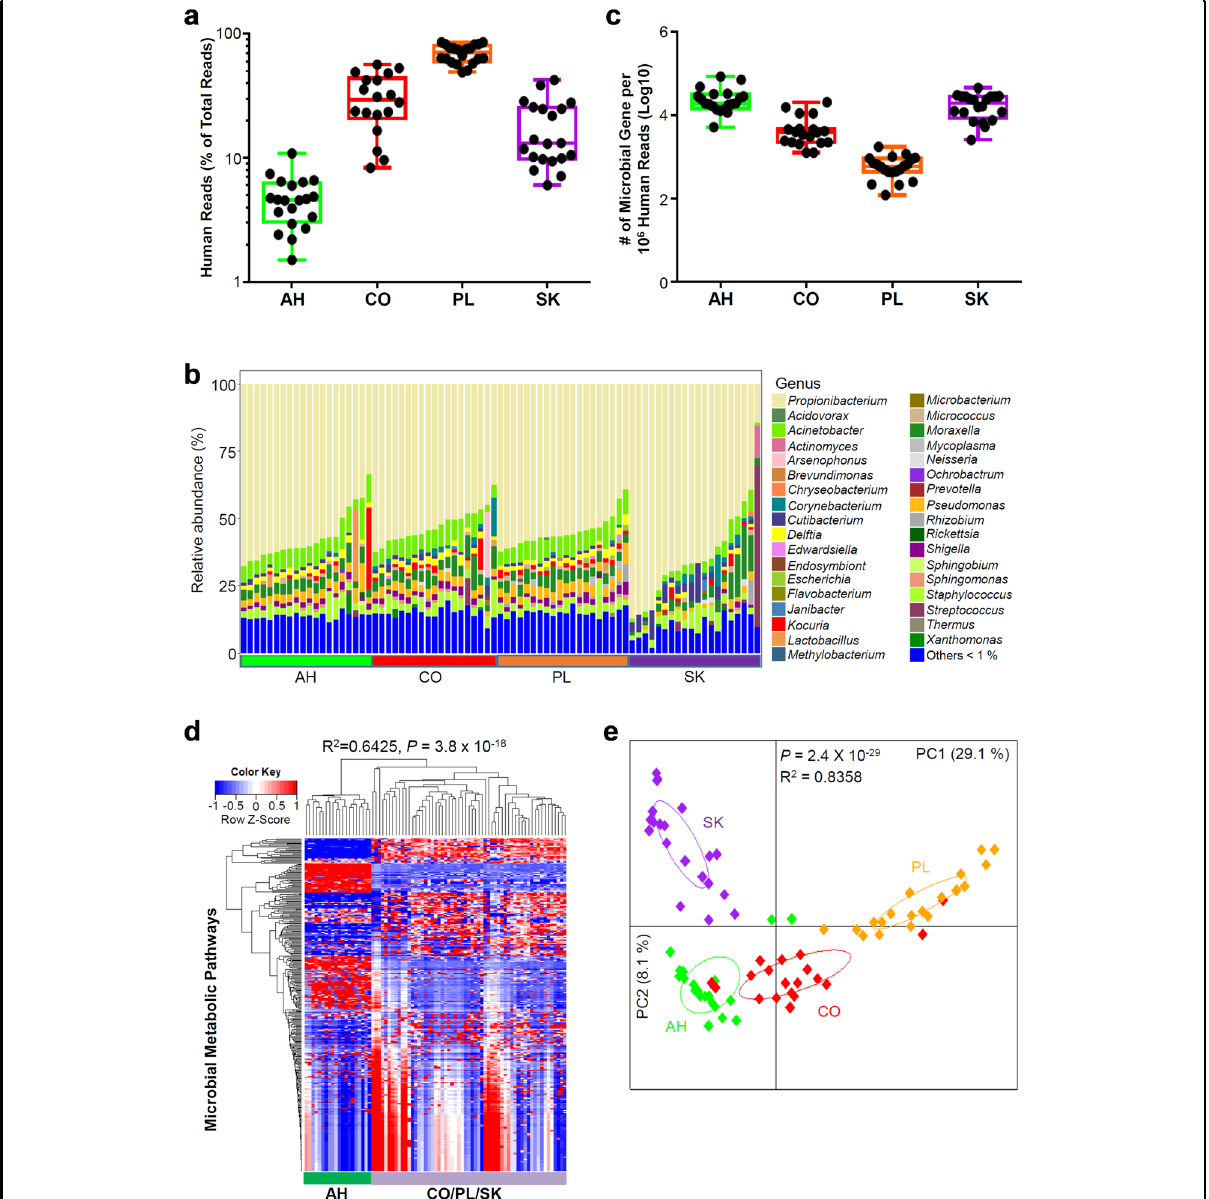
Fig. 3 A unique intraocular microbiota detected by metagenomic sequencing analysis. Comparative metagenomic analysis was performed for AH, conjunctiva (CO), plasma (PL), and skin (SK) specimens from 20 patients undergoing cataract surgery. a The average percentage of human reads among total sequenced reads from AH, CO, PL, and SK samples. b Relative abundance of the major genera of bacteria in the metagenomes of AH, CO, PL, and SK samples. c The average numbers of microbial genes identi fi ed in AH, CO, PL, and SK samples. d Hierarchical clustering analysis of relative abundance of microbial metabolic pathways identi fi ed in AH, CO, PL, and SK samples. P value was calculated using ANOVA test. e Diversity of the microbial community analyzed by PCoA. The Bray Curtis distance was used and P value was calculated using PERMANOVA